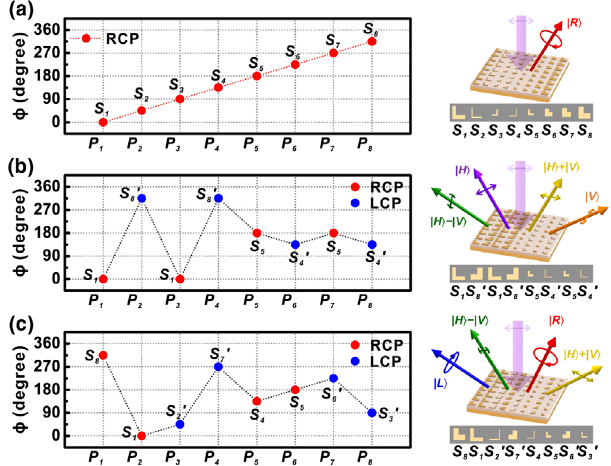
FIG. 3. GSI phase ϕ and the handedness (represented by the red or blue dots) of each resonator in the unit cell. The metasurface and the unit cell are illustrated on the right. In the unit cell, the geometrical features of each resonator vary. (a) ϕ of eight resonators all selected from f S i g with a linear phase gradient. The output is an RCP state. (b) ϕ of eight resonators, four from f S i g and four from f S 0 i g . The metasurface generates four LP states. (c) ϕ of another set of eight resonators selected from f S i g and f S 0 i g , respectively. The output is two CP and two LP